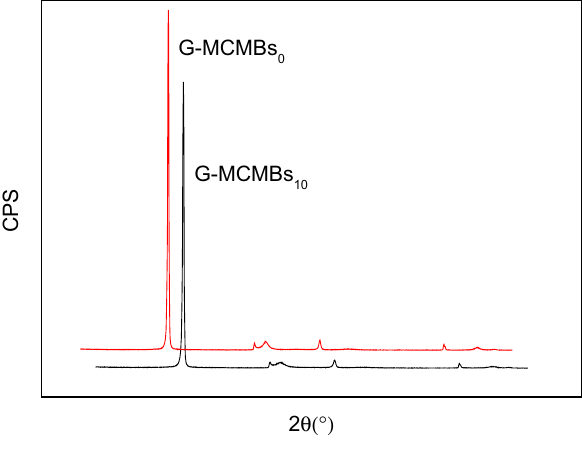
Fig. 9 XRD patterns of graphitized MCMBs 0 and MCMBs